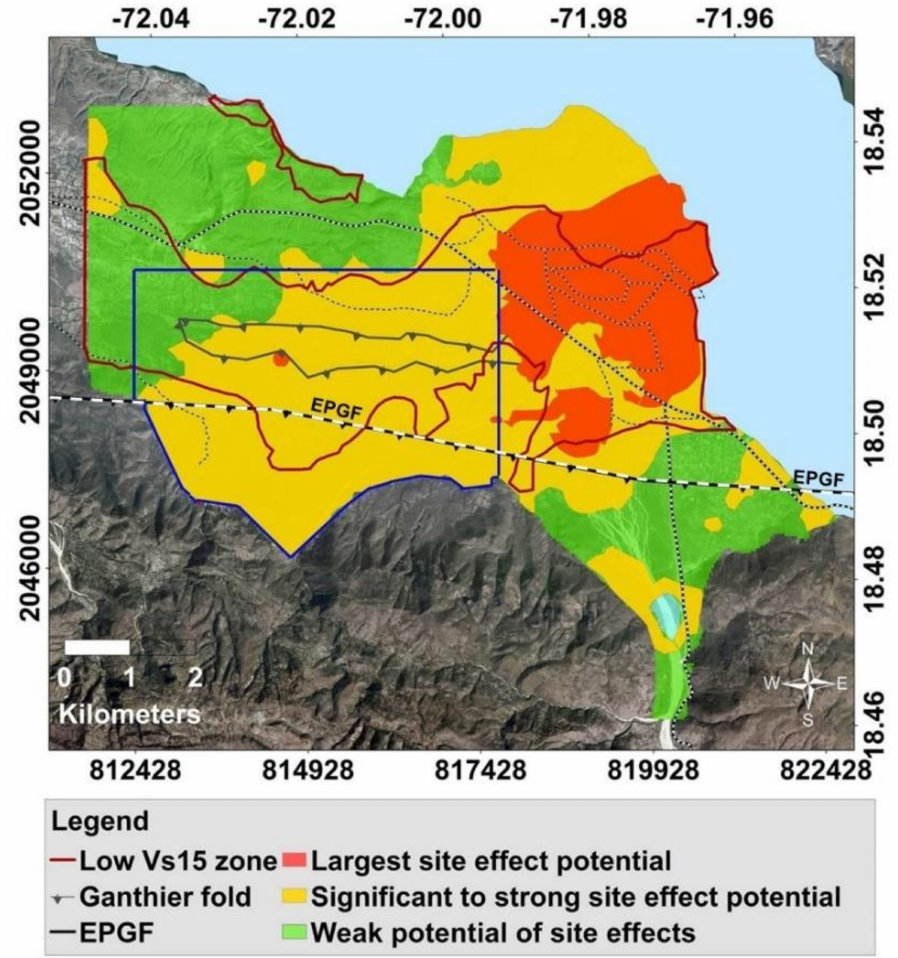
Figure 19. Map synthesizing the occurrence of the site effects across the Fond Parisien area. The zone with the largest potential of site effects, marked in red, is mostly located in the northern part of the sedimentary basin. Green shapes show the areas where the probability of the local ground shaking is weak or non-existent. The Ganthier fold is represented by the gray line. The black line shows the trace of the EPG Fault and the dark red line delimits the zones marked by low shear wave